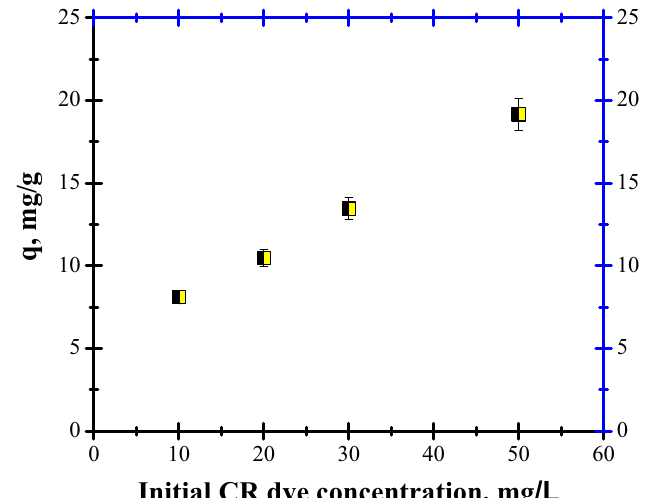
Figure 15. CR dye adsorption as a function of initial concentration.